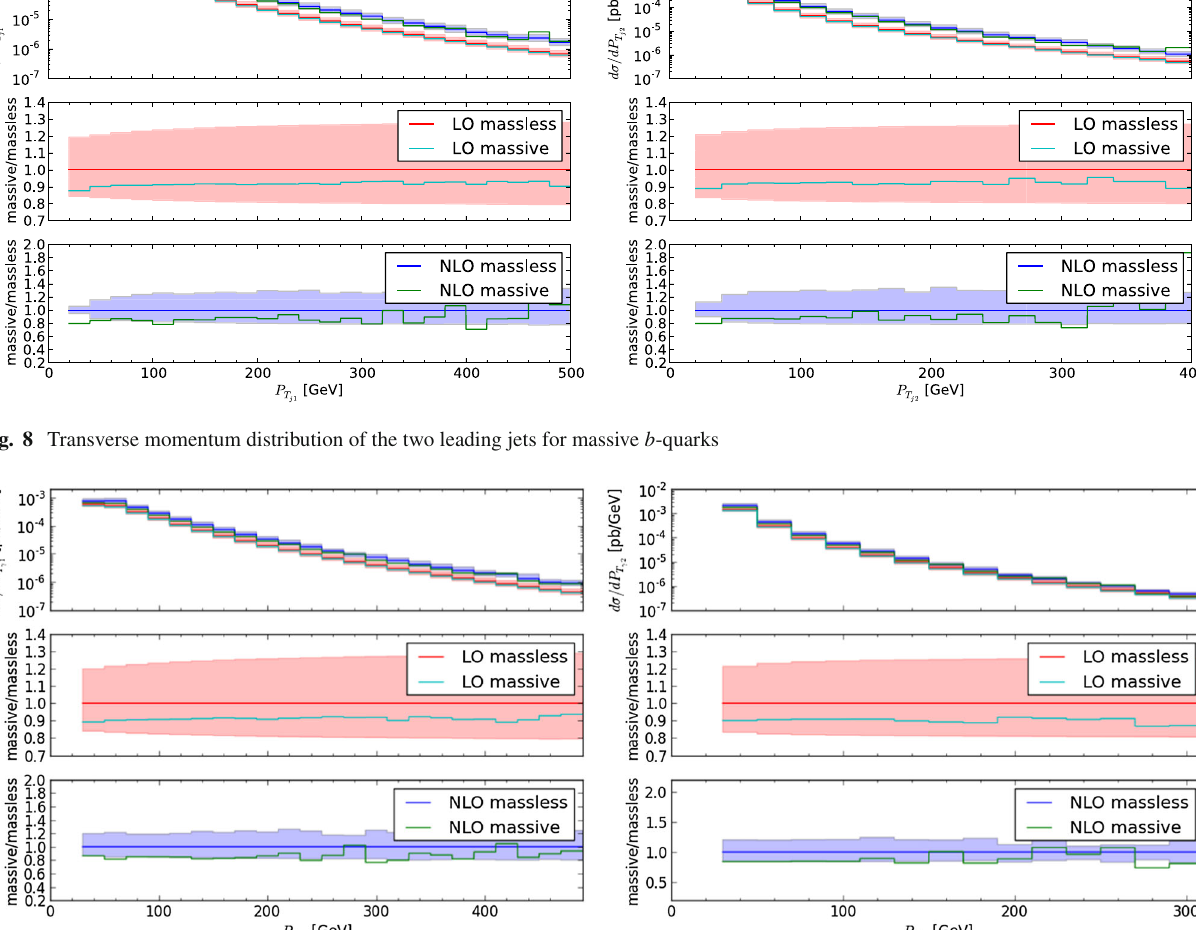
son we also show the scale uncertainty for the massless